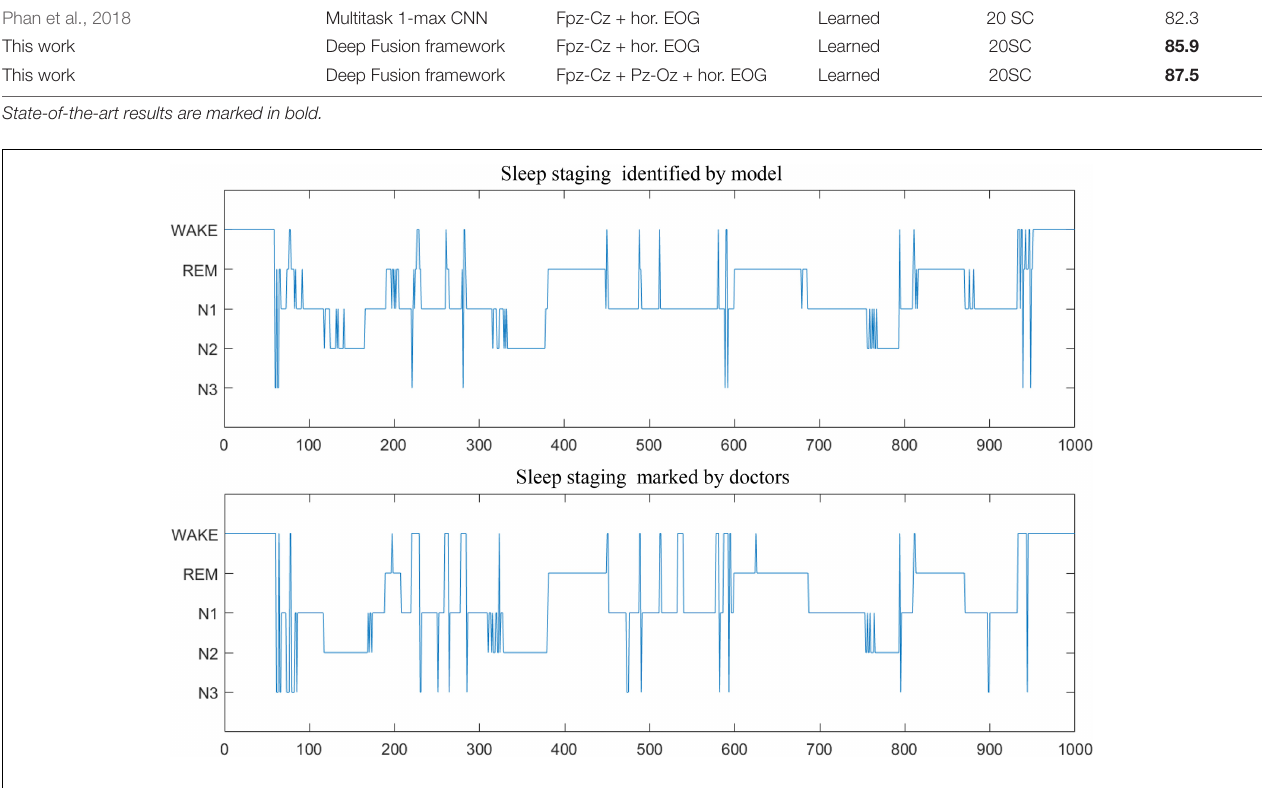
FIGURE 8 | The comparison of sleep stage